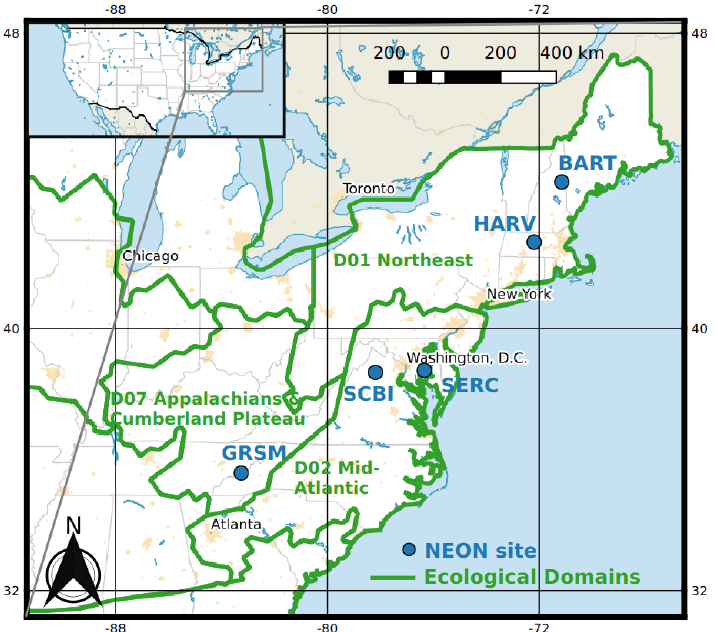
Figure 1. Map showing the location of the five National Ecological Observatory Network (NEON) sites (in blue) used in this study. Green lines represent the boundaries of the NEON ecological